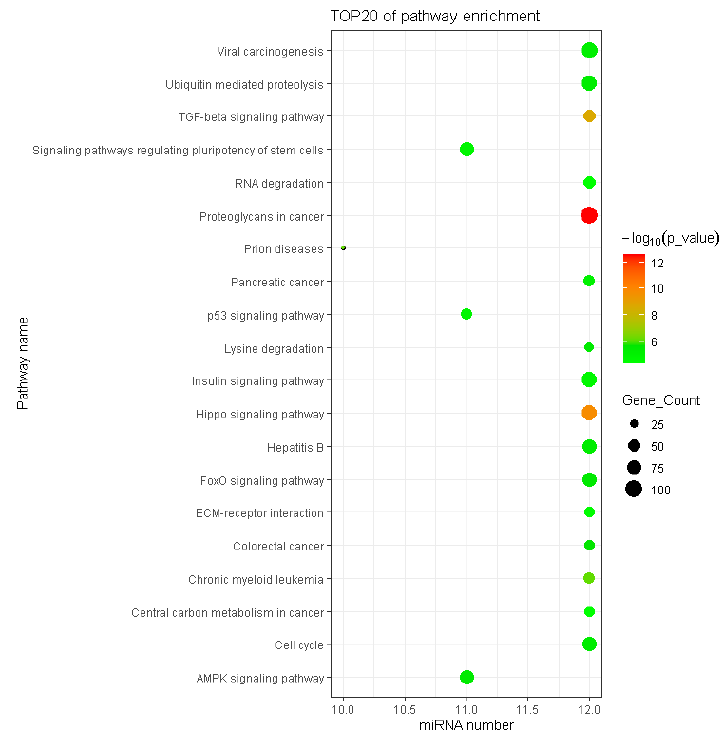
Figure 6. Pathway enrichment of target genes of DEMs.